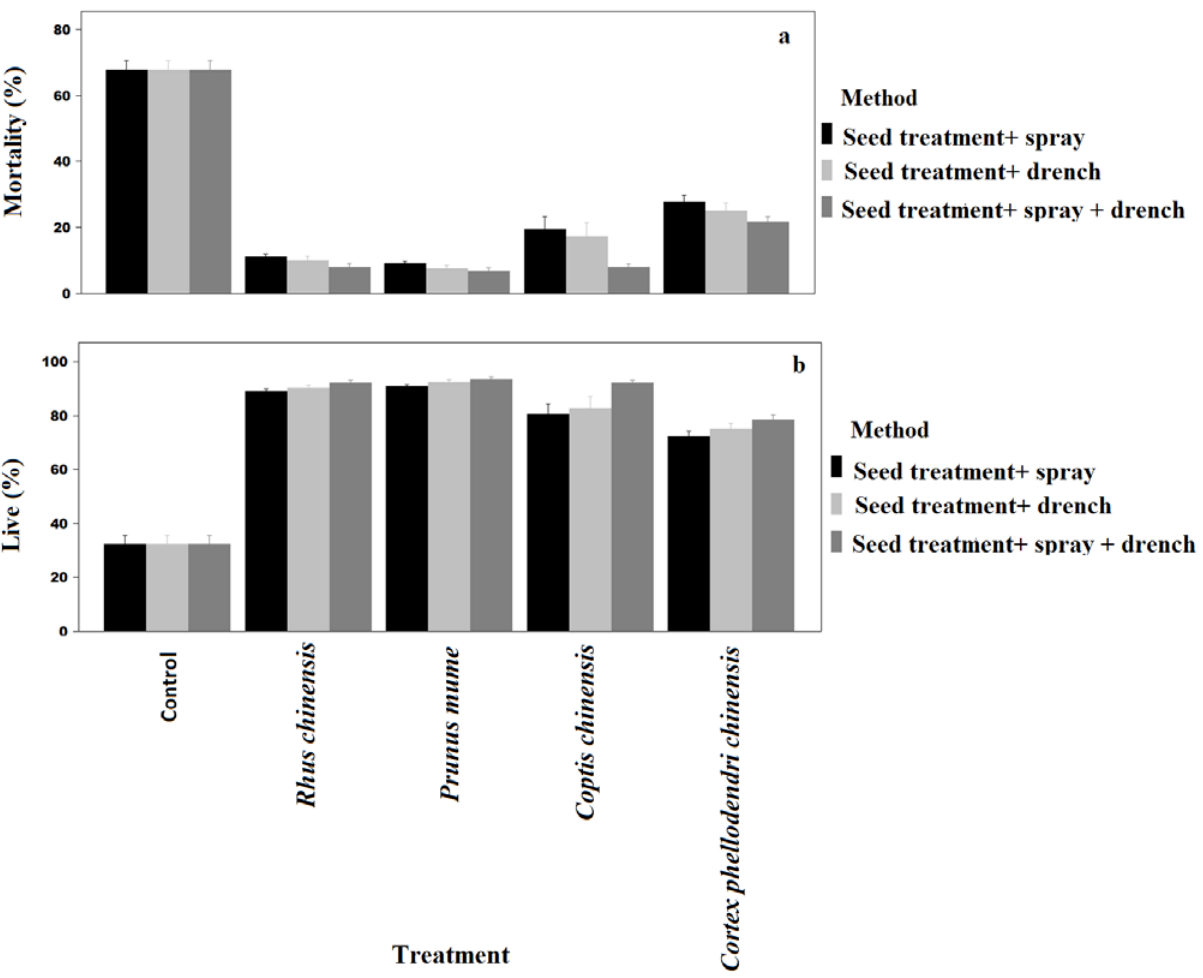
Figure 4. Mean proportions of dead and living cotton plants under greenhouse conditions, after treatment with extracts from different Chinese medicinal herbs, applied using three different